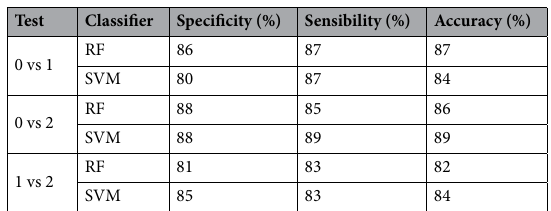
that Group 0 (curve colored in blue within the figure) is almost always greater than Groups 1 and 2 (curves in black and pink), it suggests that MultiScale Entropies (MSEs) could differentiate the healthy from COVID-19 condition. For most of the parameters, it seems that a greater distance between the parameters’ median values corresponds to those MSE maintained by the LASSO feature selection method. Moreover, even though some parameters show closer median values, for example for MSE4 in Groups 1 and 2, yet they are maintained during the three-group comparison. This could be due to the fact that during pairwise comparisons the medians and MADs of MSE4 do not assume values that justify their maintenance, while, during a three-group comparison the introduction of the third group adds an informative content that changes classes relationship, thus enabling their distinction and maintenance of the parameter by the LASSO technique. It is worthwhile noting that the number of retained MSEs increases considerably for values of the scale factor τ > 10. As previously reported, for scale factor τ = 17 , MSE17 values were retained in each comparison. This fact is also confirmed by the relative position of the medians and MADs in Fig. 2, where one can see that for this value the three groups are clearly separated and distinguishable from each other. This fact recurs, albeit with less intensity, for the parameters MSE11, MSE15 and MSE18, where the corresponding parameter is maintained in three of the four comparisons between groups. Figure 3 shows the trend of the mean and the standard deviation of the Power ( % ) parameter in the three frequency bands (VLF, LF and HF). The trend of these parameters suggests that LF Power (%) is representative of each of the classes and it is directly reflected in the Fig. 3 where this parameter is clearly different among the groups. The representativeness of MSE17 and LF Power (%) can also be found when they are employed as training parameters for the SVM and RF classifiers. In fact, it is evident that when the classifiers are trained using only the two common parameters, the results of classification are extremely high (see Tables 5, 6). Again, since the comparison in Table 6 involves three different groups, only the classifiers with higher overall accuracy param- eter were evaluated. In particular, the overall accuracy of the RF classifier is 79% while the overall accuracy of